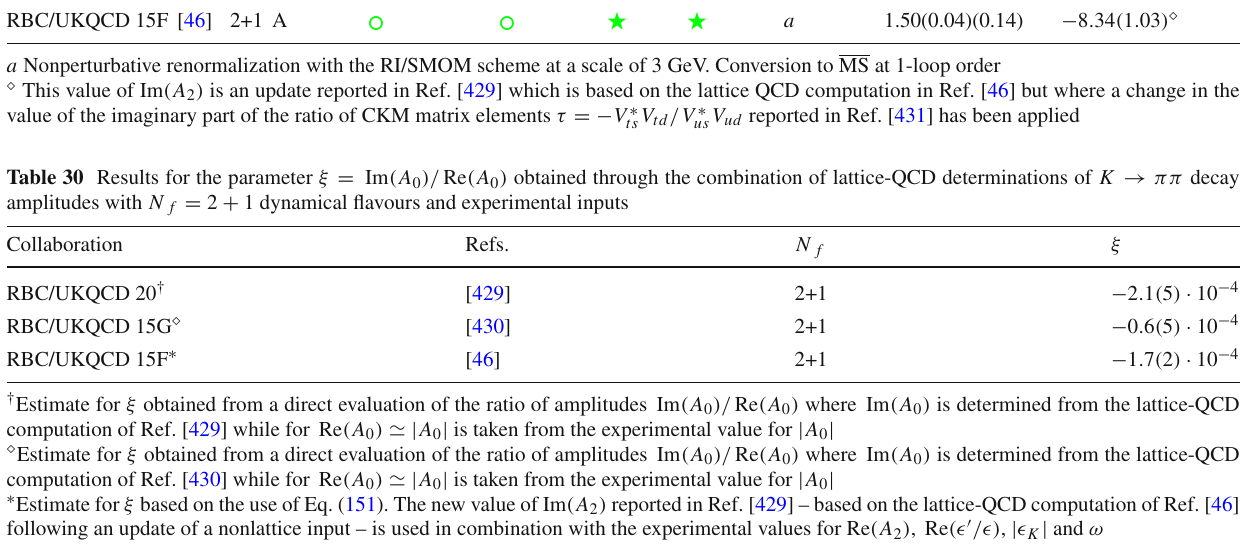
Collaboration Refs. N f P